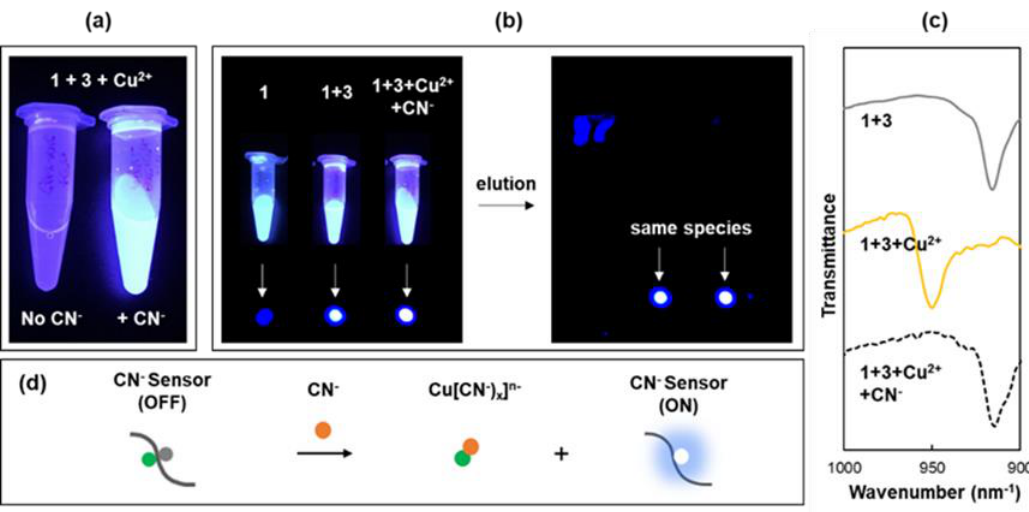
Figure 1. ( a ) Photograph of an aqueous mixture containing 0.8 mM 1 , 0.4 mM 3 and 16 mM Cu 2 + (left) and an aqueous mixture containing 0.8 mM 1 , 0.4 mM 3 , 16 mM Cu 2 + and 300 mM CN − (right) under UV illumination. ( b ) UV-illuminated ( λ EX = 350 nm) spots of 0.8 mM 1 only, a 0.8 mM 1 + 0.4 mM 3 mixture, and a 0.8 mM 1 + 0.4 mM 3 + 16 mM Cu 2 + + 300 mM CN − mixture on a TLC plate, before (left) and after (right) elution with solvent. TLC solvent system: acetonitrile / water 25:75 (w / w). TLC plates with standard silica treatment and aluminium backing are used. ( c ) Mid-FTIR spectra in the low frequency region for a 1 + 3 complex (gray line), and a 1 + 3 + Cu 2 + complex before (yellow line) and after (dashed black line) treatment with excess CN − . The 1 + 3 complex has 2:1 ( 1:3 )